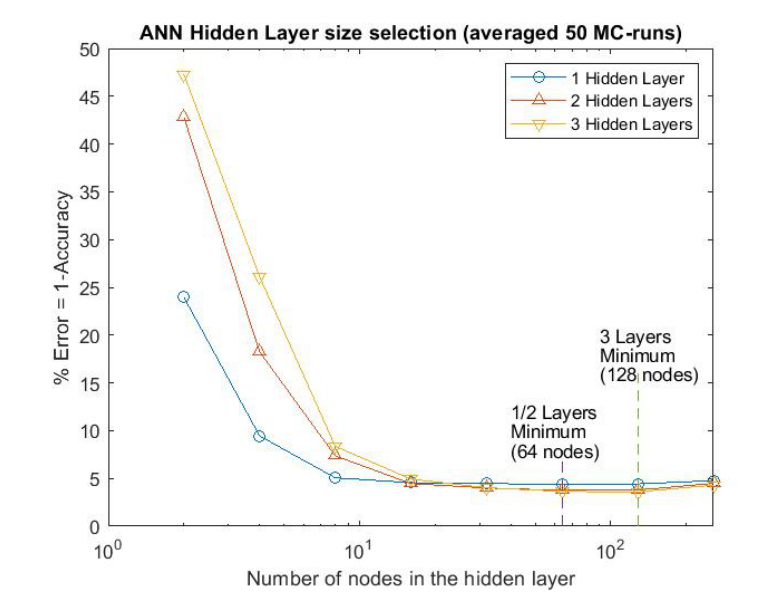
Figure 4. ANN node number